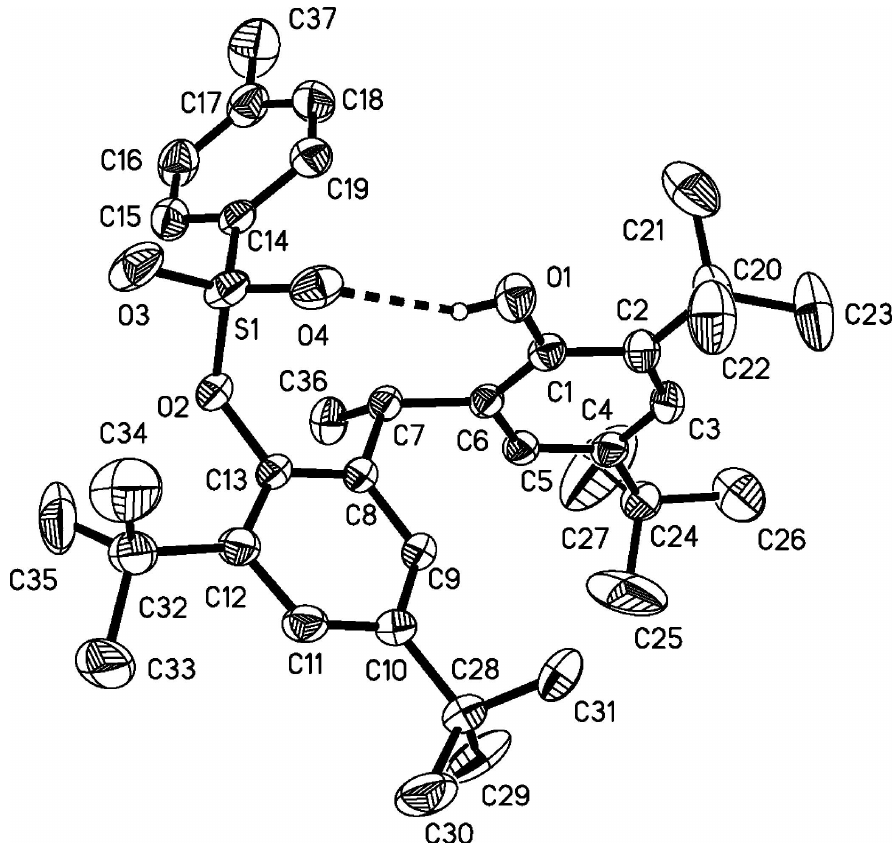
Figure 1 The structure of the title compound showing displacement ellipsoids drawn at the 30% probability level.